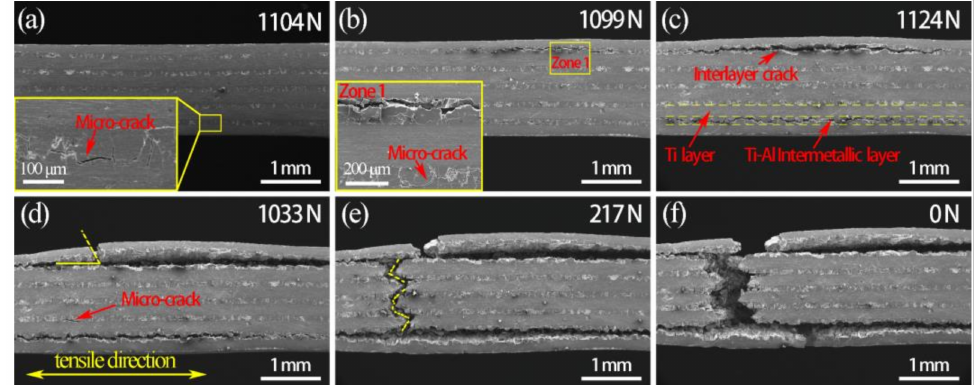
Figure 13. In situ SEM micrograph at the tensile force of ( a ) 1104 N, ( b ) 1119 N, ( c ) 1124 N, ( d ) 1033 N, ( e ) 217 N and ( f ) 0